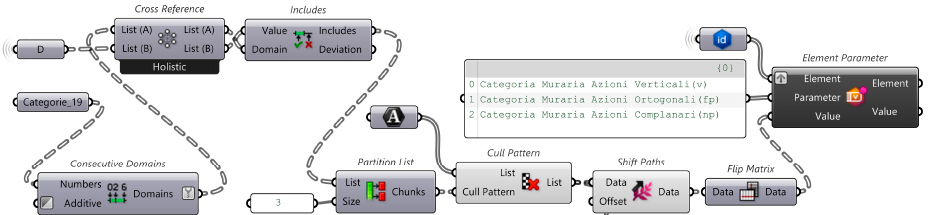
Figure 10. Last part of the code dedicated to writing the IQM category output as textual values within the instance properties